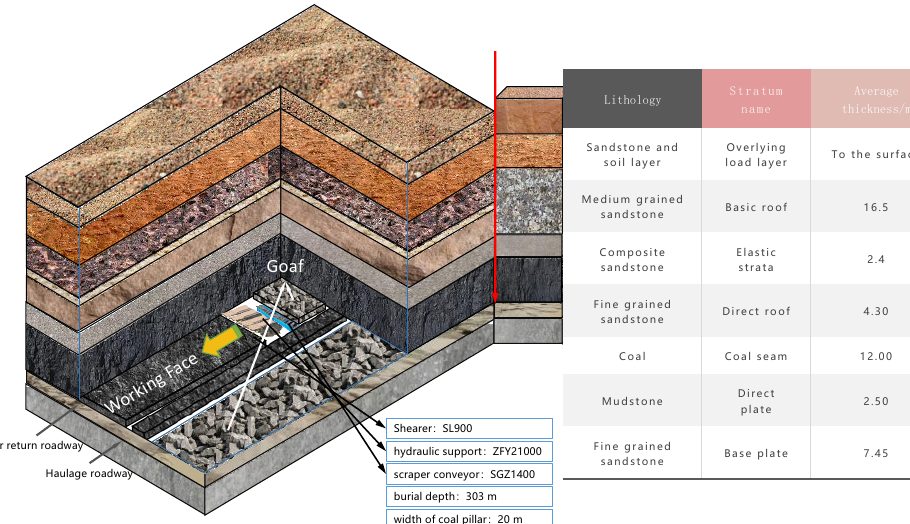
Figure 2. Comprehensive